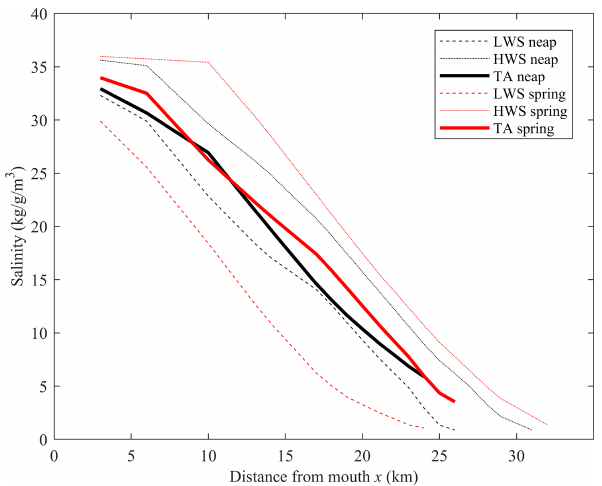
Figure 4. Vertically averaged salinity along the Guadiana Estuary at spring tide (29 May 2019; red lines) and neap tide (06 June 2018; black lines) under a river discharge of 10m 3 s − 1 . The sampling was performed at high water slack (HWS; dotted lines) and low wa- ter slack (LWS; dashed lines) every 2–4km along the channel. TA (solid lines) represents the tidally averaged